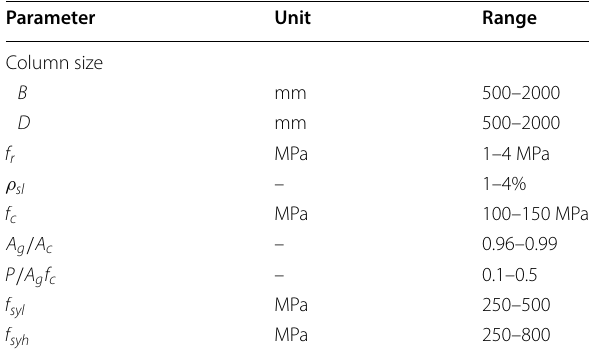
Table 4 Range of parameters for regression